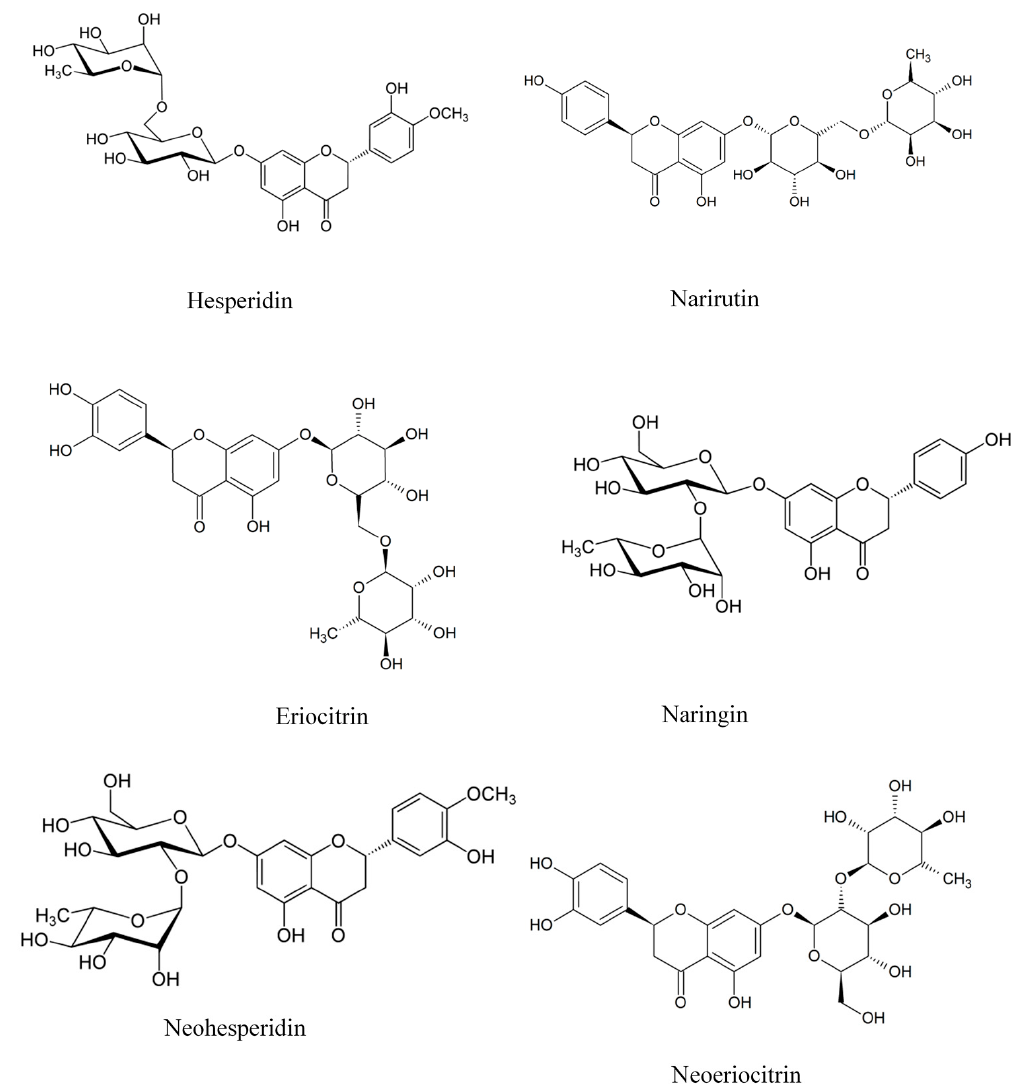
Figure 2. The most abundant flavonoids found in citrus species.